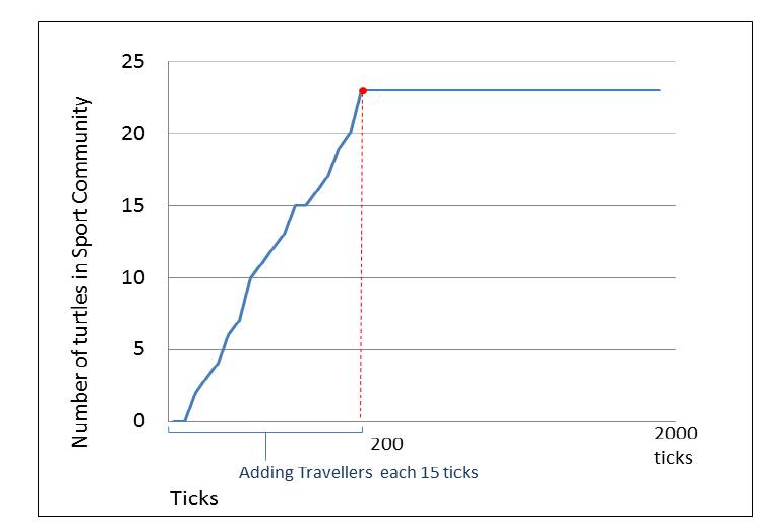
Figure 13. Changes in the sport community after removing the communication range restriction.